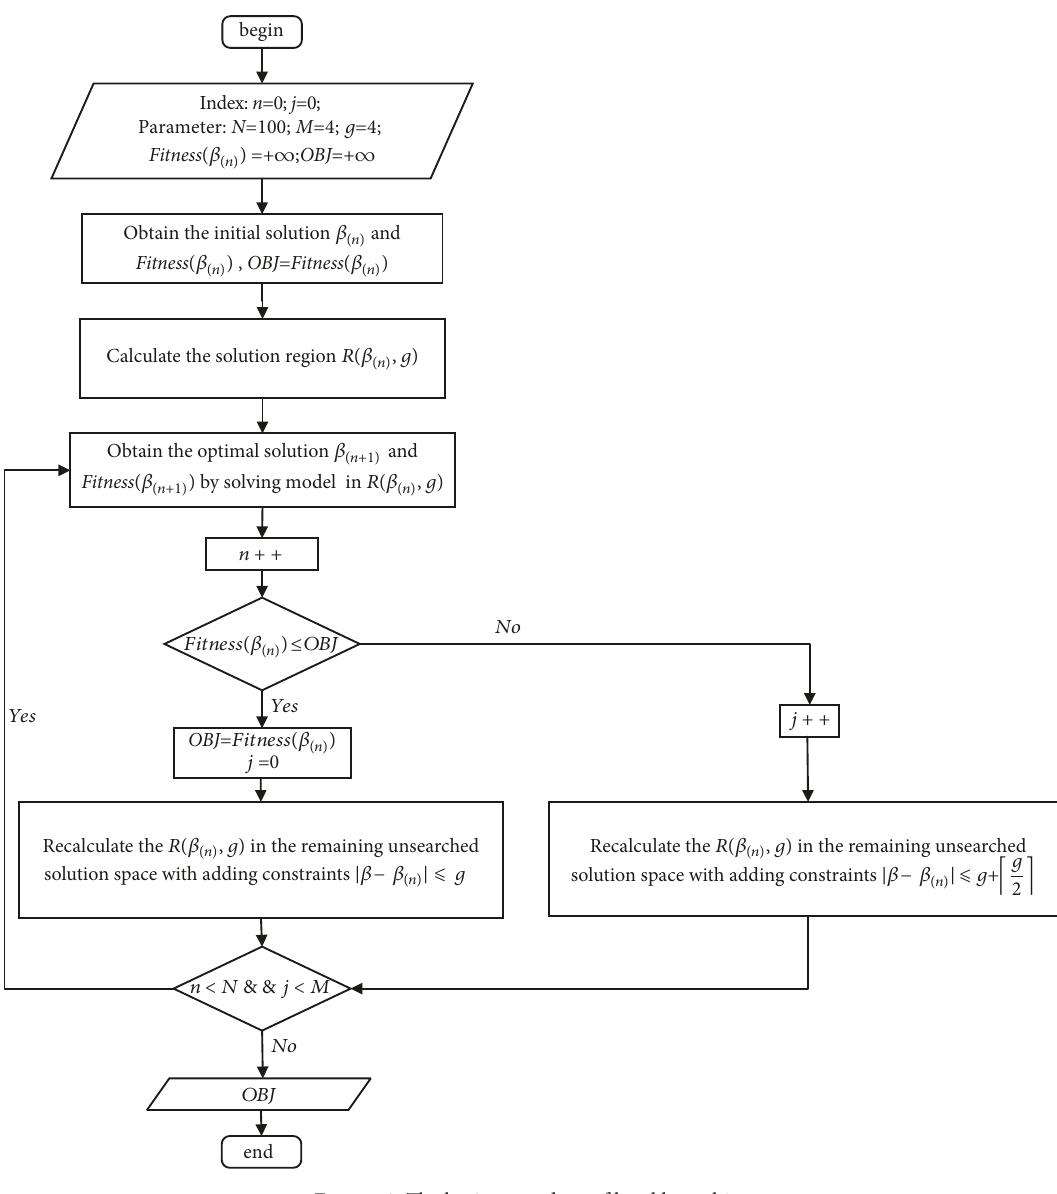
Figure 3: The basic procedure of local